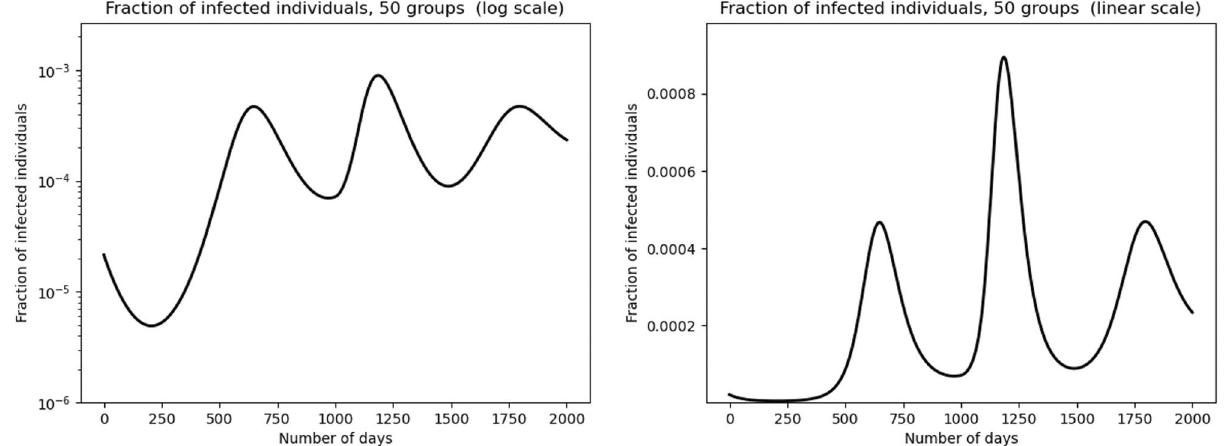
Figure 3. Multiple epidemic rebounds: susceptible individuals are divided into 50 discrete groups in the case where relaxation of social distancing measures starts on Day t = 1000 and ends up on Day t = 1100 . The fraction of infected individuals in the population is represented in the left graph in logarithmic scale and in linear scale in the right